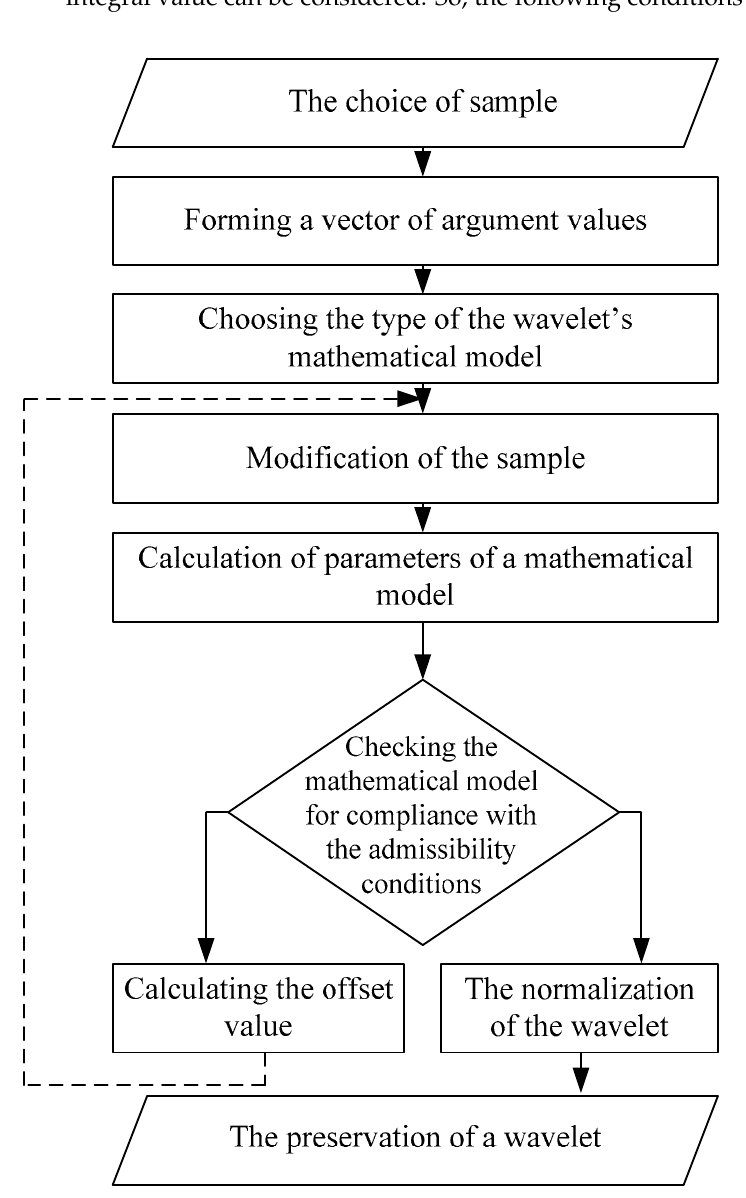
Figure 1. Modified wavelet synthesis algorithm for continuous wavelet transform of